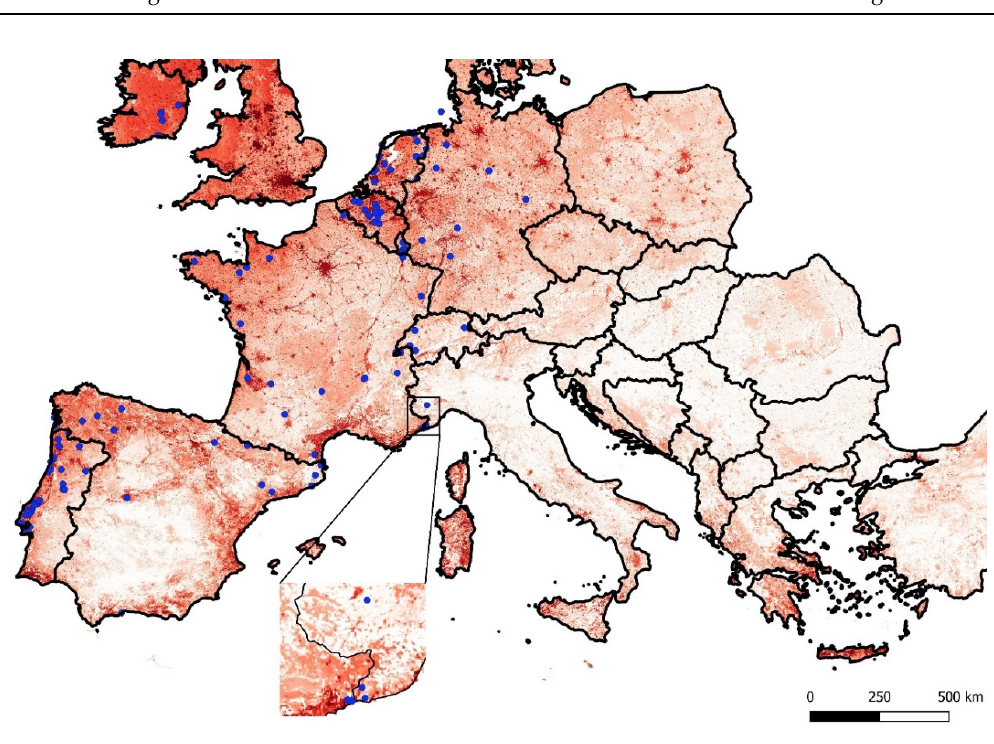
Figure 2. Potential distribution of C. russula with the occurrence records shown in light blue. White colour denotes unsuitable areas, whereas suitable areas are shown by a red gradient from poorly suitable sites in light red to highly suitable ones in dark red. The inset shows the habitat suitability in detail for eastern France and western Italy.